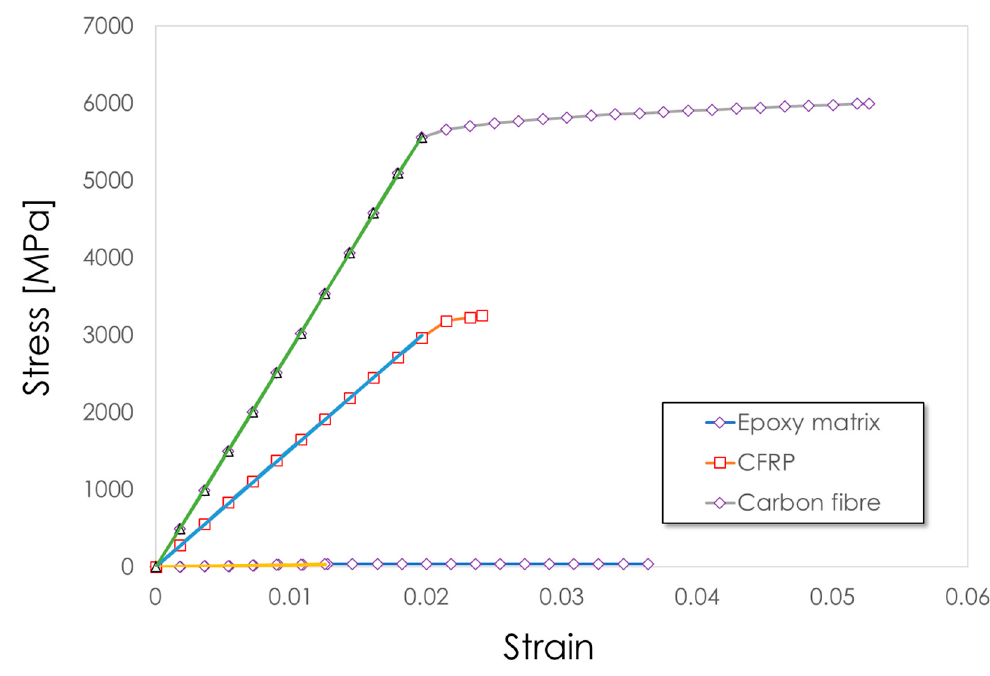
Figure 6. Engineering stress-strain plots for CFRP in tension, epoxy-matrix in tension, and carbon fibre in tension. Table 2. Properties of individual components making up TRPC, SHRPC, and CFRP, and of the final composite/pseudo- composites.